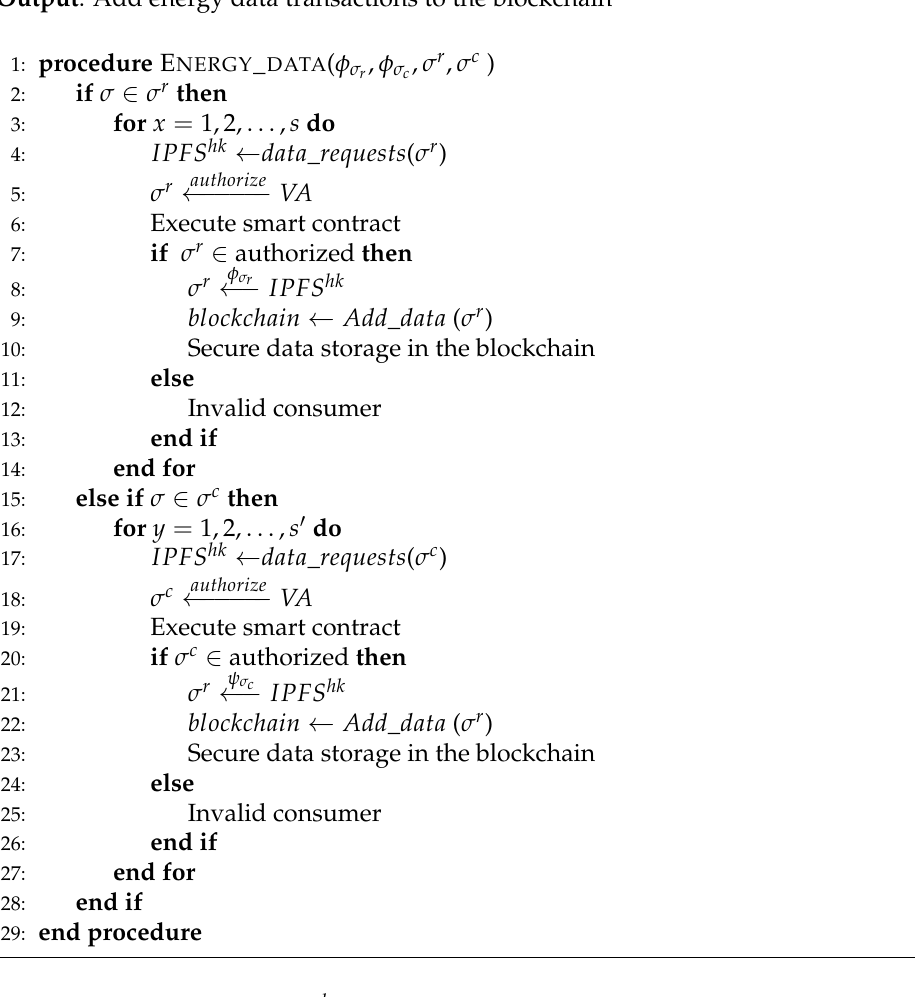
Algorithm 2 Blockchain-based algorithm for secure energy data